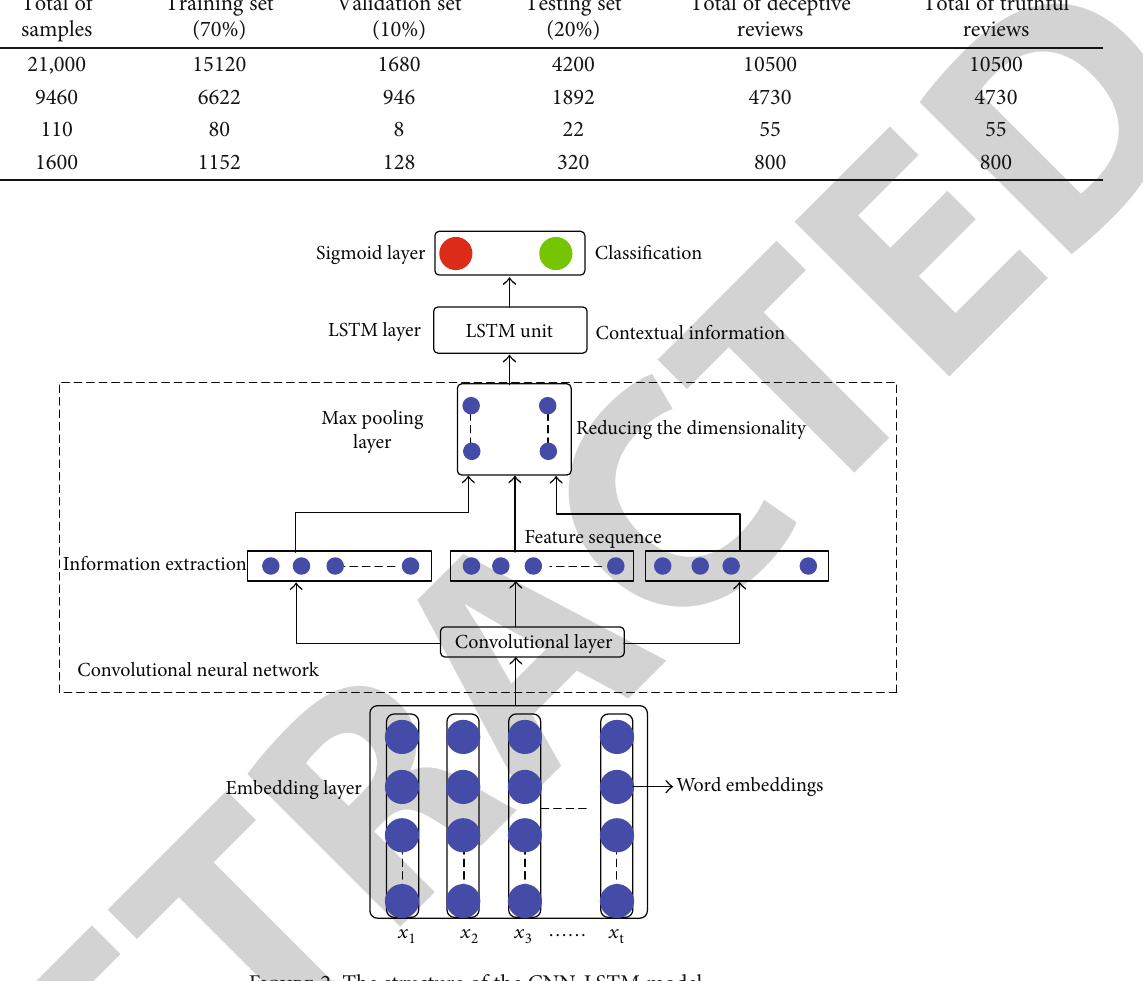
Figure 2: The structure of the CNN-LSTM